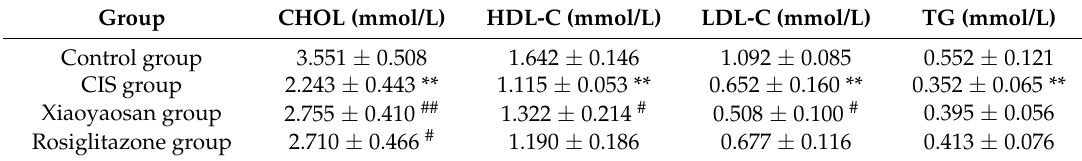
Table 1. Effects of Xiaoyaosan on plasma cholesterol (CHOL), triglyceride (TG), low-density